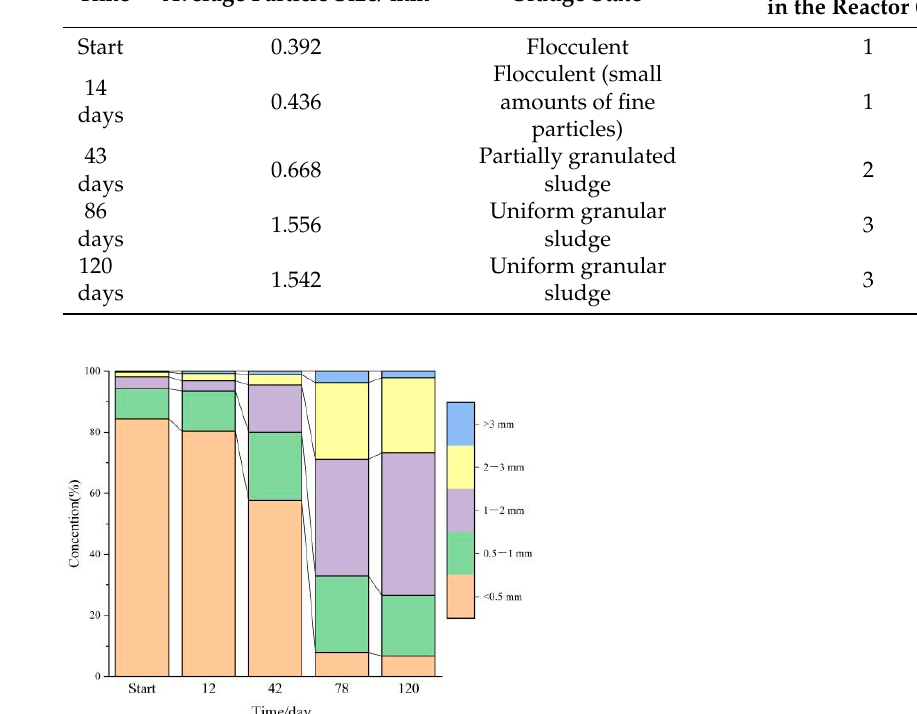
Figure 4. Major particle size distribution of sludge in the reactor.